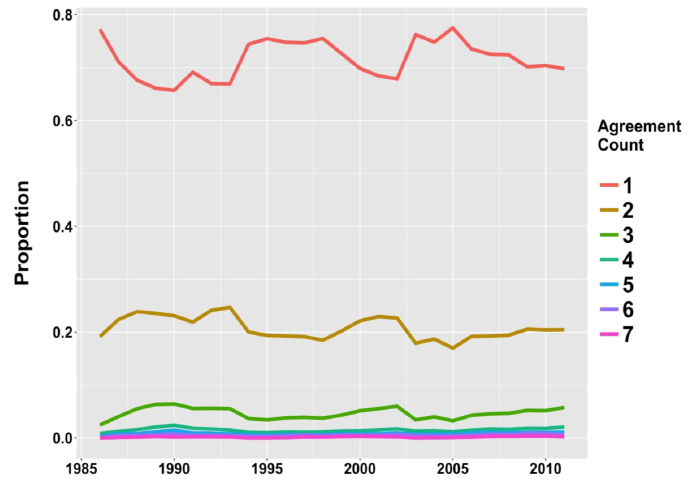
Figure 4. Agreement among seven disturbance map sets over time, as a proportion of total disturbance mapped by all algorithms.